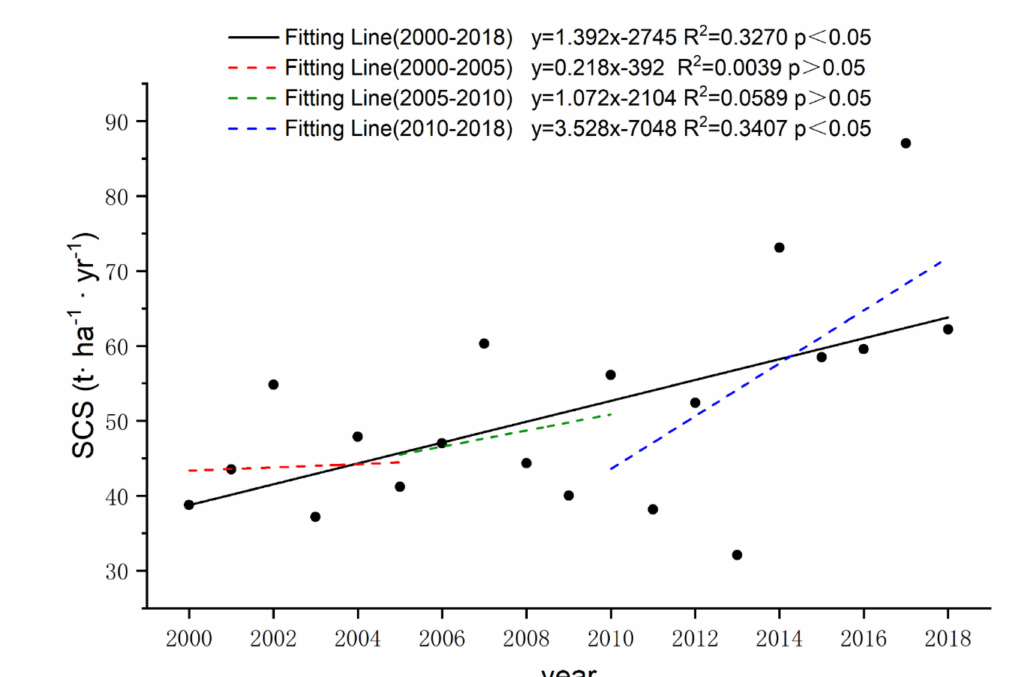
Figure 6. Interannual temporal variation trend of average SCS on the Guizhou Plateau (2000–2018). Regionally, based on the annual SCS, the area of the Guizhou Plateau with the strongest SCS was in the southeast, where non-karst landforms and peak-cluster depressions form the primary landform types. This area comprises a forest ecosystem with high vegetation coverage, low anthropogenic activity, and an excellent ecological environment. The areas with the weakest SCS function were in central and western parts of the Guizhou Plateau, characterized by karst canyons and karst plateaus with serious soil and water losses. Central parts of Guizhou Province are characterized by many cities with high levels of socioeconomic development and widespread anthropogenic activities. The areas of − 1 · − 1 greatest SCS improvement ( > 50 t · ha yr ) within the study area were primarily in the southwest, whereas the regions with the greatest deterioration were mainly in the north (Figure